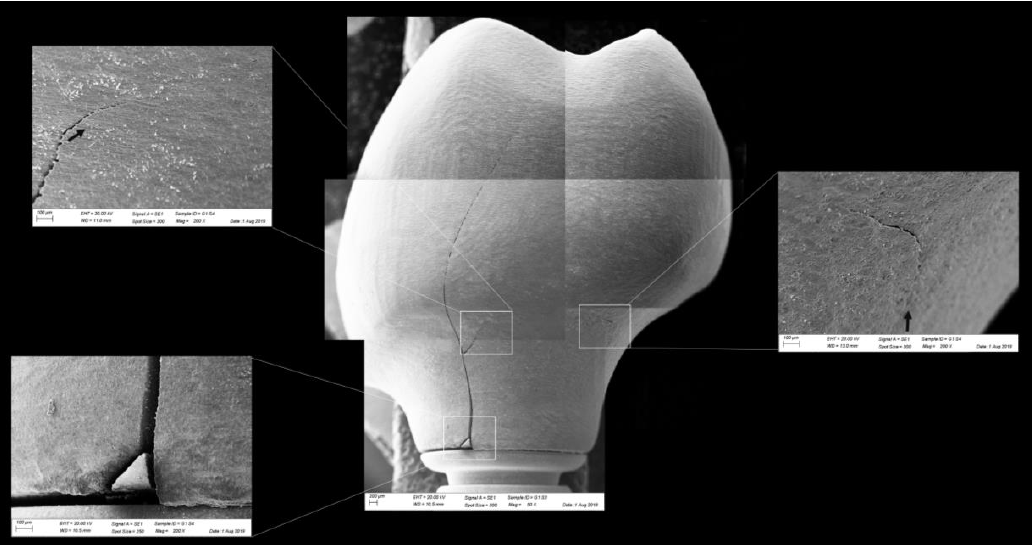
Figure 9. Fractographic analysis of a representative specimen from the MC group. The failure originated in the cervical region and propagated (black arrows) to the top of the restoration without separation of the fractured parts.